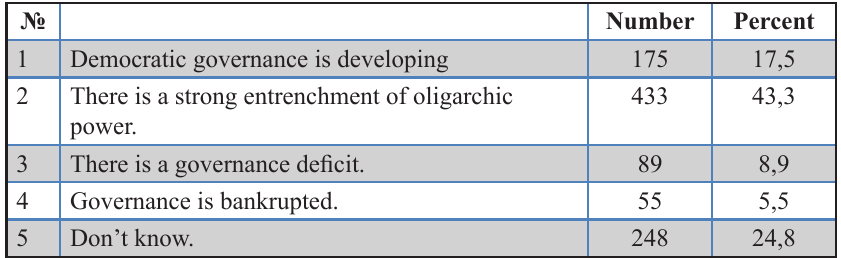
Table 9. Public Opinion about Governance in Mongolia